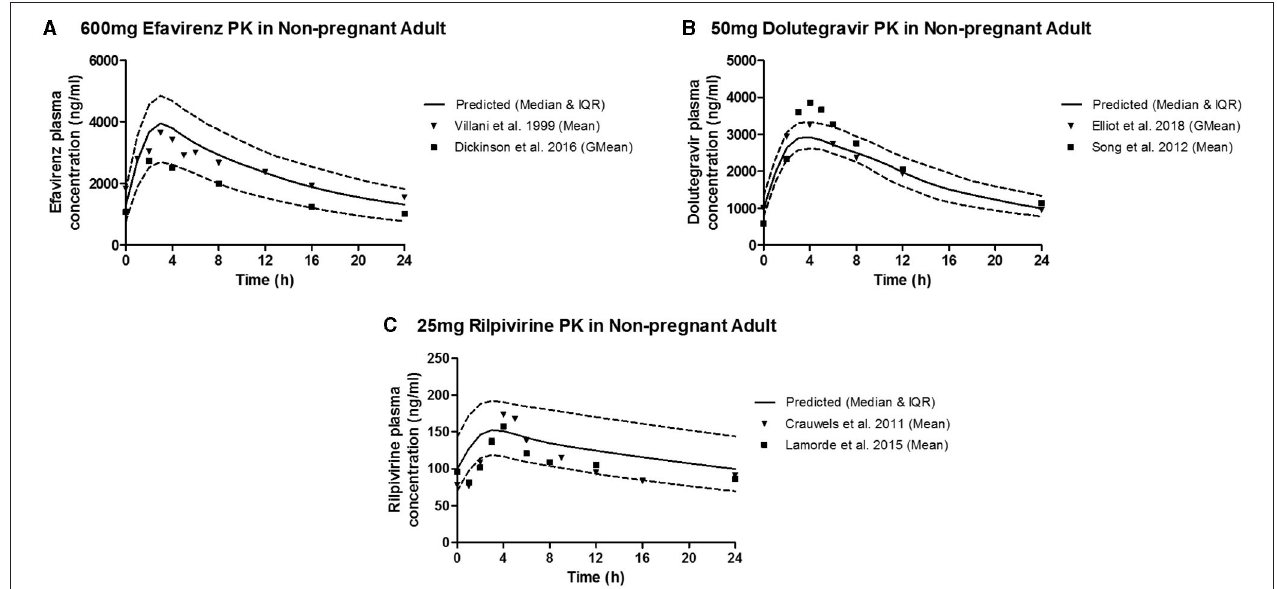
FIGURE 2 | Median (IQR) Predicted vs. Observed plasma concentration-time profile following standard dose of (A) 600mg efavirenz, (B) 50mg dolutegravir, and (C) 25mg rilpivirine in non-pregnant adults.